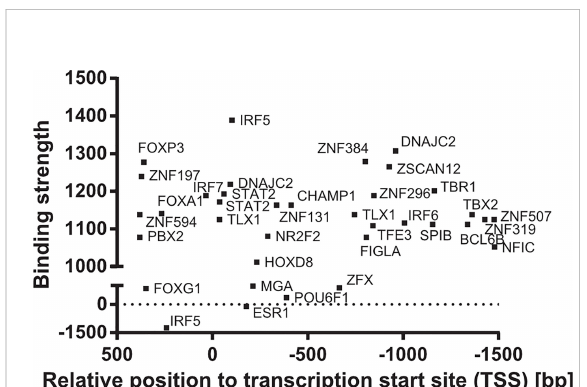
FIGURE 5 Transcription factors of MSR1 promoter. Binding sites of transcription factors in the promoter of MSR1 from experimental and theoretical sources from the TF2DNA database (70).